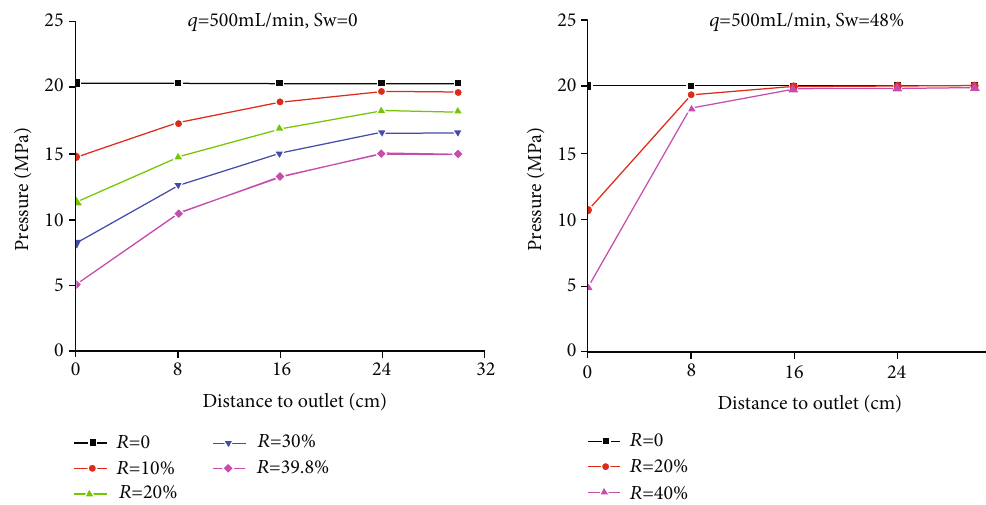
Figure 5: Comparisons of reserve utilization in the Su3 core under the dry and irreducible water